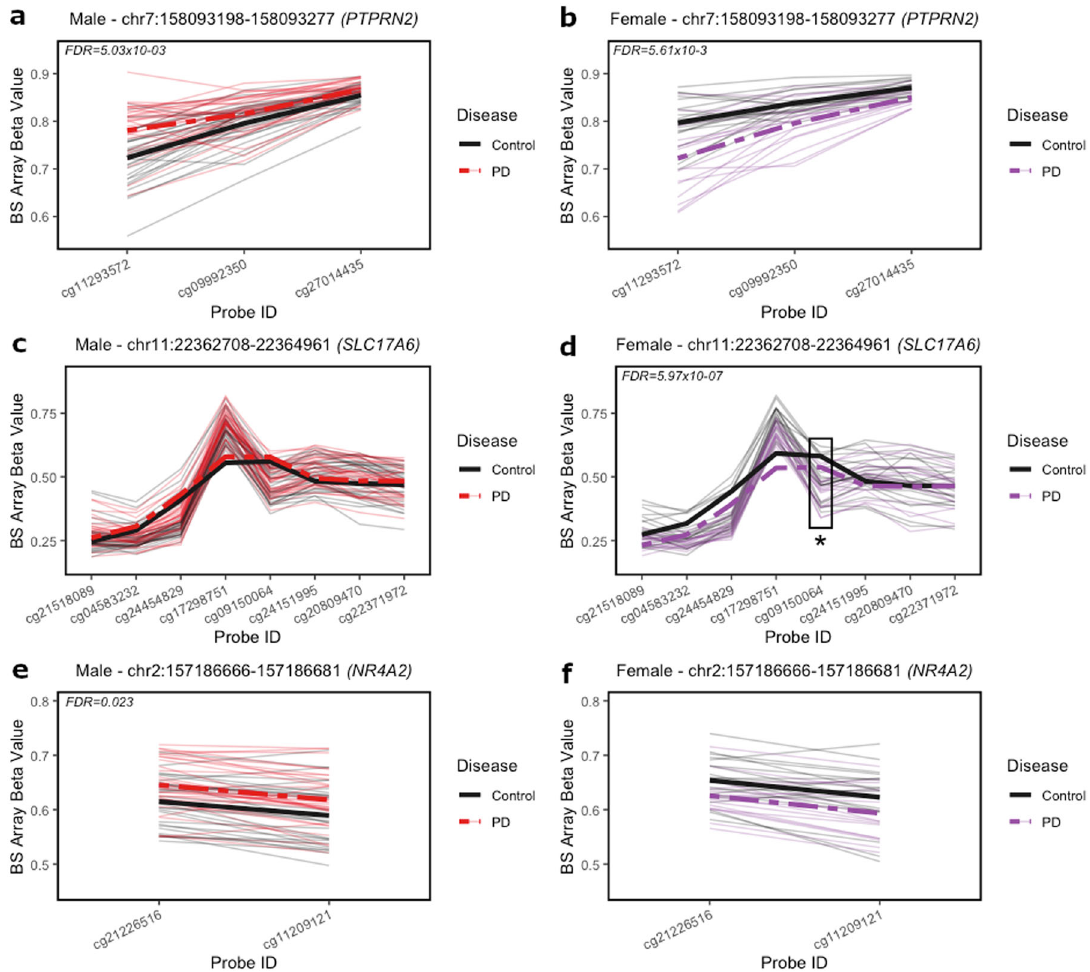
Fig. 3 Spaghetti plots of PTPRN2, SLC17A6, and NR4A2 DMRs in males and females. Beta values ( y -axis) represent DNA methylation across CpGs included in DMRs annotated to PTPRN2 (chr7: 158093198 – 158093277), SLC17A6 (chr11:22362708-22364961), and NR4A2 (chr2:157186666-157186681). a In males, PD brains (red) exhibited signi fi cant hypermethylation at PTPRN2 compared to control (black). b In females, PD brains (purple) exhibited signi fi cant hypomethylation at PTPRN2 compared to control (black). c In males, PD brains (red) did not exhibit signi fi cant differential methylation at SLC7A6 compared to control (black). d In females, PD brains (purple) exhibited signi fi cant hypomethylation at SLC17A6 compared to control (black). Signi fi cant DMC (cg09150064) indicated with box and asterisk. e In males, PD brains (red) exhibited signi fi cant hypermethylation at NR4A2 compared to control (black). f In females, PD brains (purple) did not exhibit signi fi cant differential methylation compared to control (black). Signi fi cant DMRs are indicated with minimum smoothed FDR values < 0.05. Thick solid and dashed lines represent smoothed means by group across